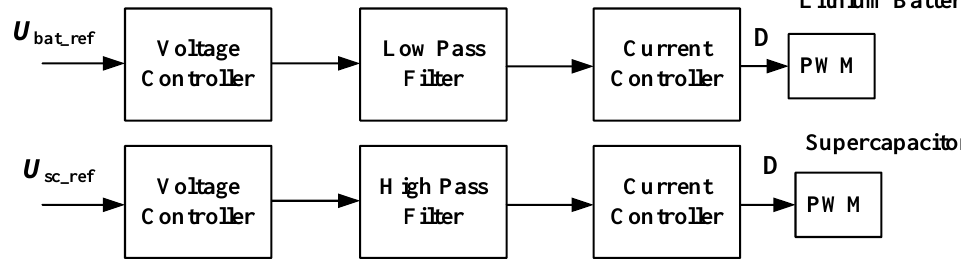
Figure 11. Control block diagram with filter added between the double closed loop. In Figure 11, U bat and U sc _ ref indicate the voltage reference values of the lithium battery and the supercapacitor, respectively, while D indicates the duty